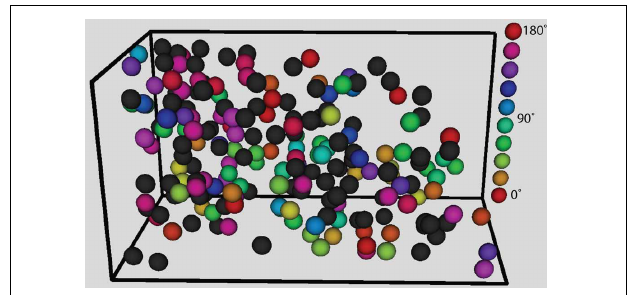
FIGURE 8 | The three-dimensional visualization of orientation preference for a single recording site. Black spheres indicate cells that were not significantly tuned. The color of the other spheres indicates the orientation preference. The column on the right indicates the corresponding orientation indicated by the colors.